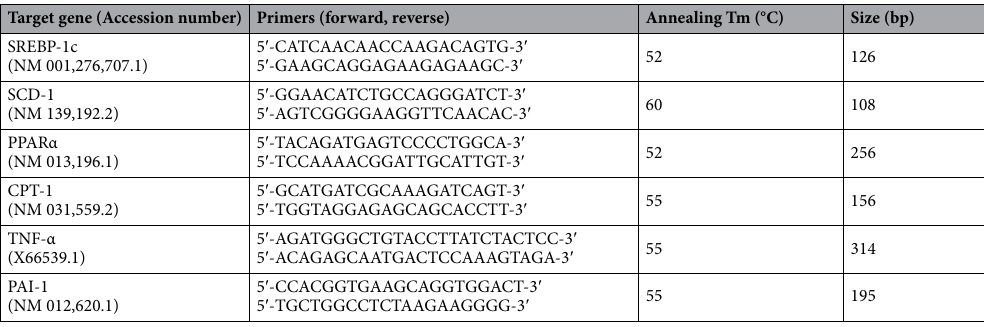
Table 3. Primer sequences and conditions for real-time PCR. Data are expressed as mean ± SE. LETO, Long-Evans Tohushima Otsuka; LETO-Allo, LETO rats treated with allopurinol; OLETF, Otsuka Long-Evans Tokushima Fatty rats; OLETF-Allo, OLETF rats treated with allopurinol; OLEFT-HFrD, OLETF rats fed with high fructose diet; OLETF-HFrD-Allo rats, OLETF rats fed with high fructose diet which were treated with allopurinol; HFrD, high fructose-diet; AUC, Area under the curve; IGI 30, insulinogenic index 30 min (ΔInsulin30/ΔGlucose30); IGI 120, insulinogenic index 120 min (ΔInsulin120/ΔGlucose120); HOMA-beta, homeostatic model assessment of beta cell function; HOMA-IR, homeostatic model assessment of insulin resistance. † P < 0.05 versus LETO group, * P < 0.05 versus OLETF group, # P < 0.05 versus OLETF-HFrD group.